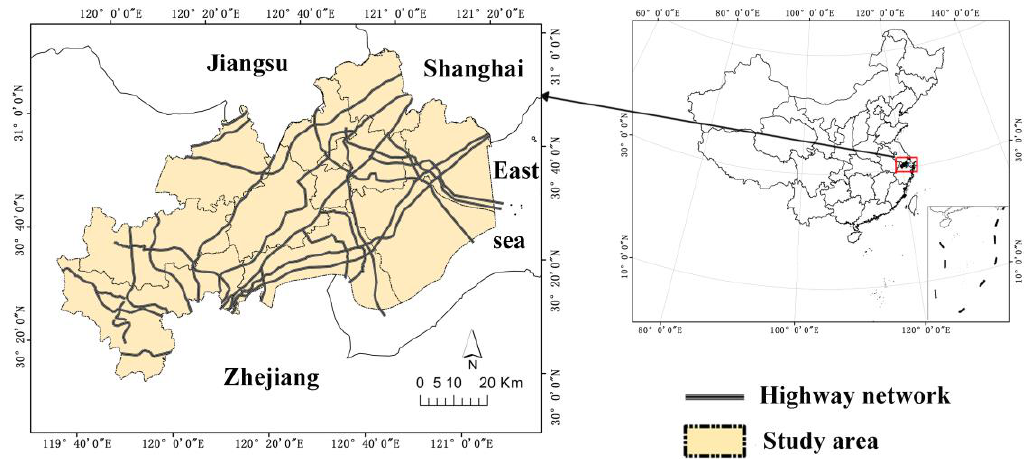
Figure 1. Location of the Hang-Jia-Hu Plain and spatial patterns of the highway network.